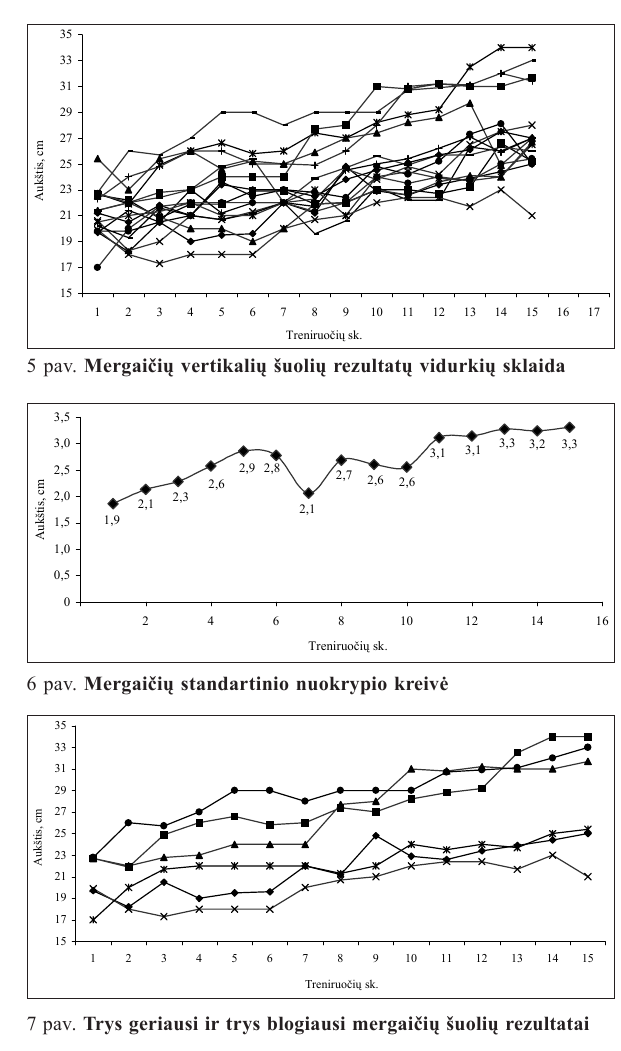
90 o kampo. Rank ų pad ė tis (cid:151) ant juosmens. Re- miantis C. Bosco ir P. Komi (1979) metodika, Rodiklis Am(cid:158)ius, buvo apskai č iuojamas vertikalaus (cid:154)uolio auk(cid:154)tis (h). Per vien ą treniruo č i ų dien ą kiekviena mer- gait ė atlikdavo po 50 vertikali ų (cid:154)uoli ų . Intervalai daugiau kaip 6 cm. Vertikali ų (cid:154)uoli ų aritmetini ų tarp (cid:154)uoli ų (cid:151) 30 sekund(cid:158)i ų . Rekomenduota (cid:154)uol į vidurki ų analiz ė rodo pama(cid:158)u ger ė jan č ius (cid:154)uoli ų atlikti kiek į manoma auk(cid:154) č iau, stengiantis pa- rodiklius. Rezultatai skiriasi nereik(cid:154)mingai iki gerinti asmenin į rezultat ą . (cid:154)e(cid:154)tos treniruot ė s. Skirtumas statisti(cid:154)kai patikimas Vertikal ū s (cid:154)uoliai buvo fiksuojami u(cid:158)ra(cid:154)ant (p < 0,05) nuo septintos treniruot ė s, j ą lyginant su kiekvieno (cid:154)uolio auk(cid:154)t į į asmenin į kiekvienos pirma. Mergai č i ų (cid:154)uoli ų rezultatai treniruojantis moksleiv ė s protokol ą . ger ė ja l ė tai, bet tolygiai. TYRIMO REZULTATAI I(cid:154)analizavus mergai č i ų rezultat ų ger ė jimo spart ą ir palyginus su pirma treniruote (3 pav.) Tirt ų mergai č i ų am(cid:158)iaus, ū gio ir svorio para- matyti, kad rezultatai nuosekliai kyla. Tik 1 ir 2, metrai pateikti lentel ė je. 8 savaites ugdant mer- bei 5 ir 6 treniruot ė s (cid:154)uoli ų rezultat ų vidurkiai gai č i ų (cid:154)oklum ą (buvo atliekama po 50 (cid:154)uoli ų kas buvo ma(cid:158)daug vienodi, visi kiti rezultatai mer- 30 s maksimaliai pa(cid:154)okant), (cid:154)uoli ų vidurkiai nuo- gait ė ms reguliariai treniruojantis pama(cid:158)u ger ė ja. sekliai did ė ja. I(cid:154) rezultat ų , pateikt ų 2 paveiksle, Stebint mergai č i ų (cid:154)uoli ų rezultat ų vidurki ų matyti, kad tiriam ų j ų (cid:154)uoli ų vidurki ų rezultatas po procentin ė s i(cid:154)rai(cid:154)kos kait ą , 4 paveiksle matyti, 15 treniruo č i ų pager ė ja nuo 21,2 iki 27,5 cm (cid:151) kad procentin ė (cid:154)uoli ų i(cid:154)rai(cid:154)ka, lyginant su pirma treniruote, nuolatos did ė ja. (cid:138)uoli ų rezultat ų prie-